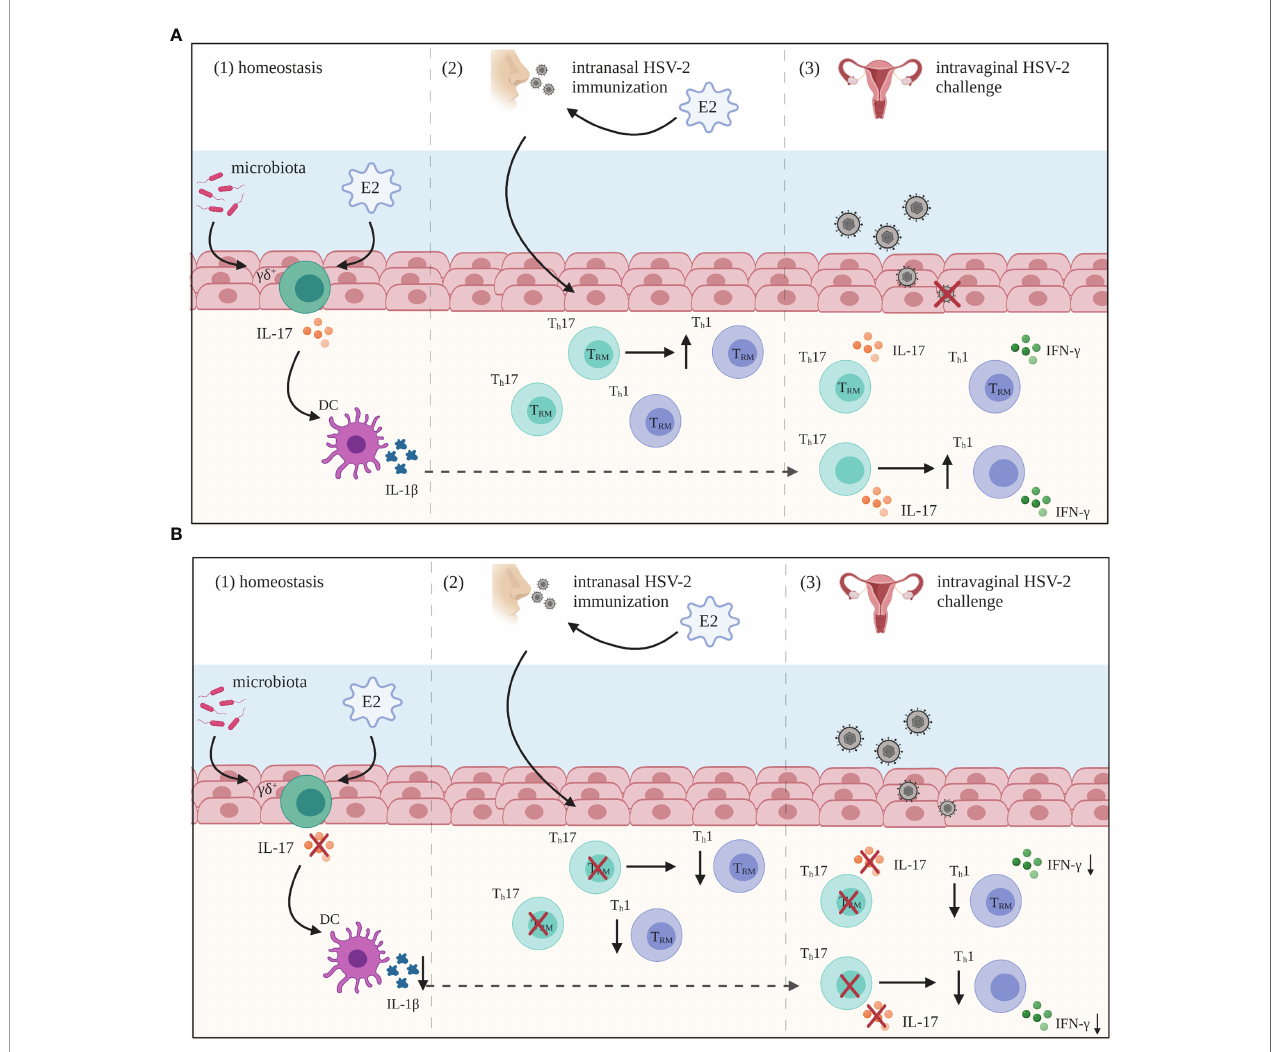
FIGURE 3 | Summary of IL-17 mediated anti-HSV-2 immunity in the FRT. (A) (1) During periods of homeostasis, IL-17 is constitutively produced by innate lymphocyte populations, primarily gamma delta ( gd +) T cells, and regulated by estradiol (E2) and commensal microbiota. This innate IL-17 is important for the induction of Th17 responses primed by vaginal dendritic cells (DCs). (2) Following intranasal HSV-2 immunization under the in fl uence of E2, IL-17 is important for the establishment of Th1 tissue-resident memory (TRM) cells in the female reproductive tract (FRT). (3) These Th17 and Th1 TRM cells are then able to protect against subsequent HSV-2 challenge. Additionally, IL-17 is critical for inducing IFN- g + CD4+ T cell recall responses in the FRT post-challenge. (B) In the absence of IL-17, there is reduced Th17 immunity generated (1), and overall anti-viral Th1 responses are signi fi cantly lowered both post-immunization (2) and post-challenge (3), even in the presence of E2. As a result, there is less protection generated against HSV-2 infection in the FRT. Created with